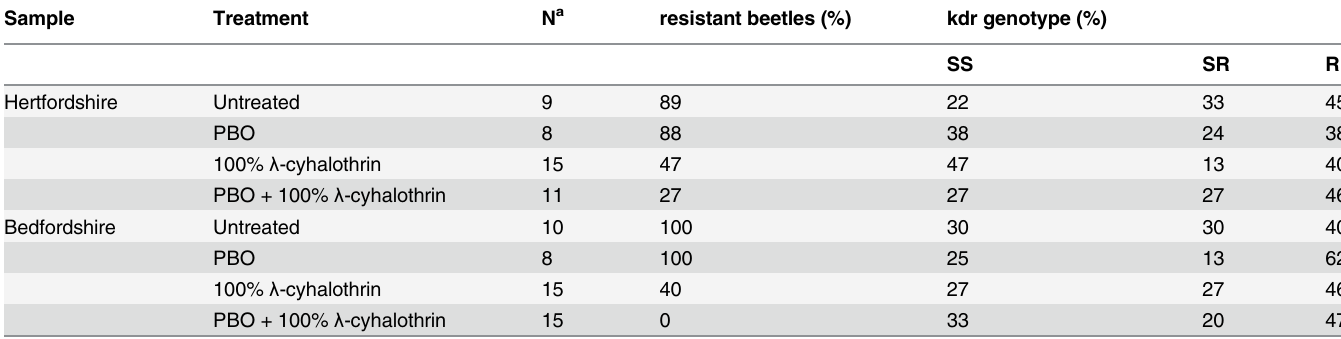
Table 3. Effect of pre-treatment with the synergist PBO in two UK cabbage stem flea beetle samples.